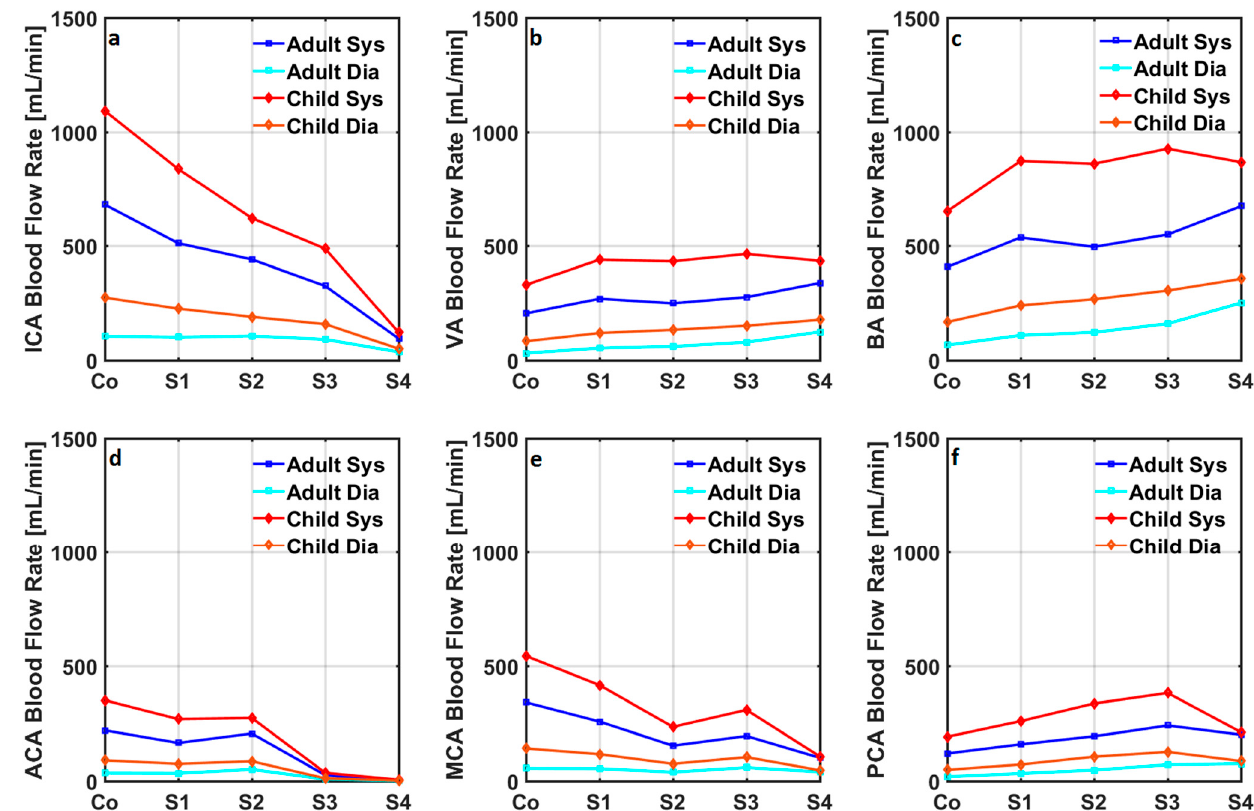
Figure 6. Systolic and diastolic cerebral blood flow rates in ( a ) internal carotid arteries (ICA), ( b ) vertebral arteries (VA), ( c ) basilar artery (BA), ( d ) anterior cerebral arteries (ACA), ( e ) middle cerebral arteries (MCA), and ( f ) posterior cerebral arteries (PCA) in the adult and child cardiovascular system models simulating a healthy condition and advancing stages of the Moyamoya disease together with coarctation of the aorta. H, S, Sys, and Dia represent healthy, stage, systolic, and diastolic. Coarctation of the aorta resulted in increased systolic and diastolic blood flow rates in the cerebral circulation, whereas the progression of Moyamoya disease caused a similar change in the blood flow rates in each compartment as in the cardiovascular system models not simulating coarctation of the aorta. Systolic and diastolic aortic blood pressures, cardiac output, total cerebral blood flow rate, and mean blood flow rates through the internal carotid, vertebral, basilar, anterior cerebral, middle cerebral, and posterior cerebral arteries in the numerical models simulating healthy conditions and advancing stages of the Moyamoya disease with and without coarctation of the aorta are given in Table 1. Progression of Moyamoya disease had little effect on the systolic and diastolic pres- sures in the aorta and cardiac output in both adult and child cardiovascular system models without coarctation of the aorta. On the other hand, the progression of Moyamoya disease Table 1. Systolic and diastolic aortic blood pressures (SBP and DBP), cardiac output (CO), total had a more profound effect on the systolic and diastolic pressures in the aorta and cardiac cerebral blood flow rate (CBF), and mean cerebral blood flow rates in the internal carotid, vertebral, output in the cardiovascular system models simulating coarctation of the aorta. Progres- basilar, anterior, middle, and posterior arteries (ICA, VA, BA, ACA, MCA, and PCA) in the adult sion of Moyamoya disease decreased total cerebral blood flow rate in both adult and child and child cardiovascular system models simulating healthy conditions and advancing stages of the cardiovascular system models with and without coarctation of the aorta, whereas total Moyamoya disease with and without coarctation of the aorta. cerebral blood flow rate was relatively high in the cardiovascular system models simulating coarctation of the